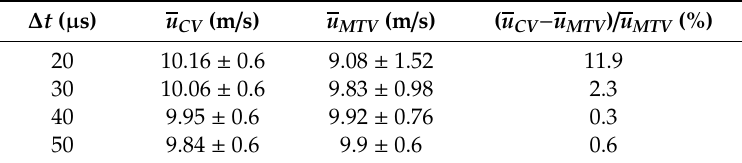
Table 7. Average velocities u CV and u MTV with estimated uncertainties, and relative deviation between u CV and u MTV calculated for the image data of Figure 15. The uncertainty range has a confidence level of 95%.